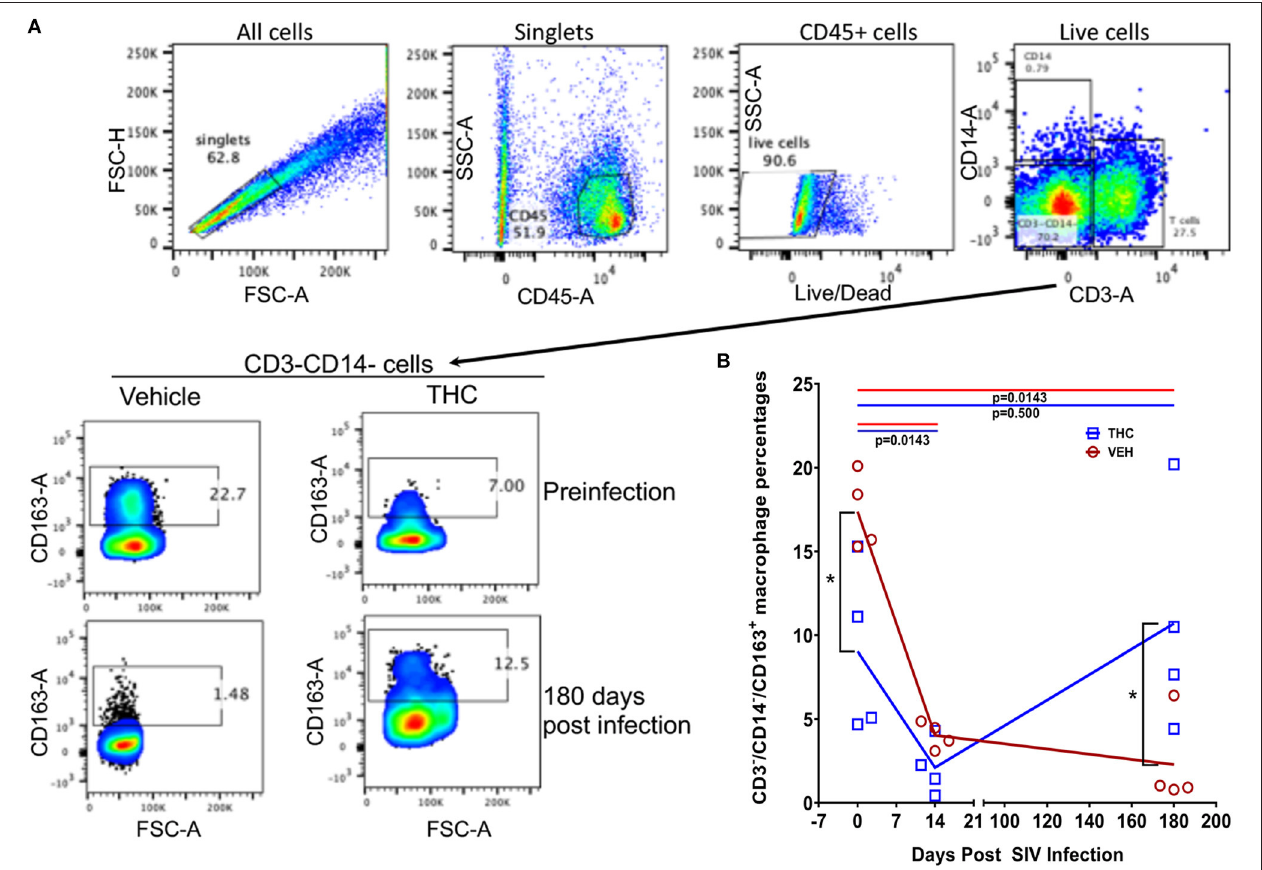
FIGURE 10 | Delta-9-tetrahydrocannabinol ( 1 9 -THC) administration increased the percentage of CD163 expressing anti-inflammatory macrophages in intestine after SIV infection. To quantify CD163 + anti-inflammatory macrophages, cells were gated first on singlets, CD45 + cells, followed by live cells and then on CD3 − CD14 −− cell subsets to quantify CD163 + cells (A) . Frequencies of CD163 + cells at preinfection and 180 days post-infection are shown from a representative THC/SIV and VEH/SIV rhesus macaque (A) . The percentages of the total gated population are shown in each box of the plot. Note that the THC/SIV infected animal had significantly higher CD163 + cells compared to VEH/SIV infected animal at 180 days post-SIV infection (A) . Open red circles- VEH/SIV, Open blue squares- THC/SIV. Horizontal red and blue lines with P -values denote comparisons between time points within the VEH/SIV and THC/SIV groups, respectively. Left black brackets with an asterisk indicate statistical significance ( p = 0.0286) between the VEH/SIV and THC/SIV groups for a given time point. Connecting blue and red lines (B) denote mean values of the respective population in the THC/SIV and VEH/SIV groups, respectively. Flow cytometry analysis to determine the effect of 1 9 -THC on CD163 expression in intestinal macrophages of SIV-infected rhesus macaques was performed once with four individual animals as biological replicates per group. Flow cytometry data were analyzed using linear mixed models with immune-marker outcomes being dependent variables, and treatment status (VEH vs. 1 9 -THC) and days since the start of treatment (0, 14, 150, 180) being dependent variables with fixed effects. Differences between two time points were analyzed using the Mann-Whitney U -test employing the Prism v5 software (GraphPad software). A p -value of ≤ 0.05 was considered